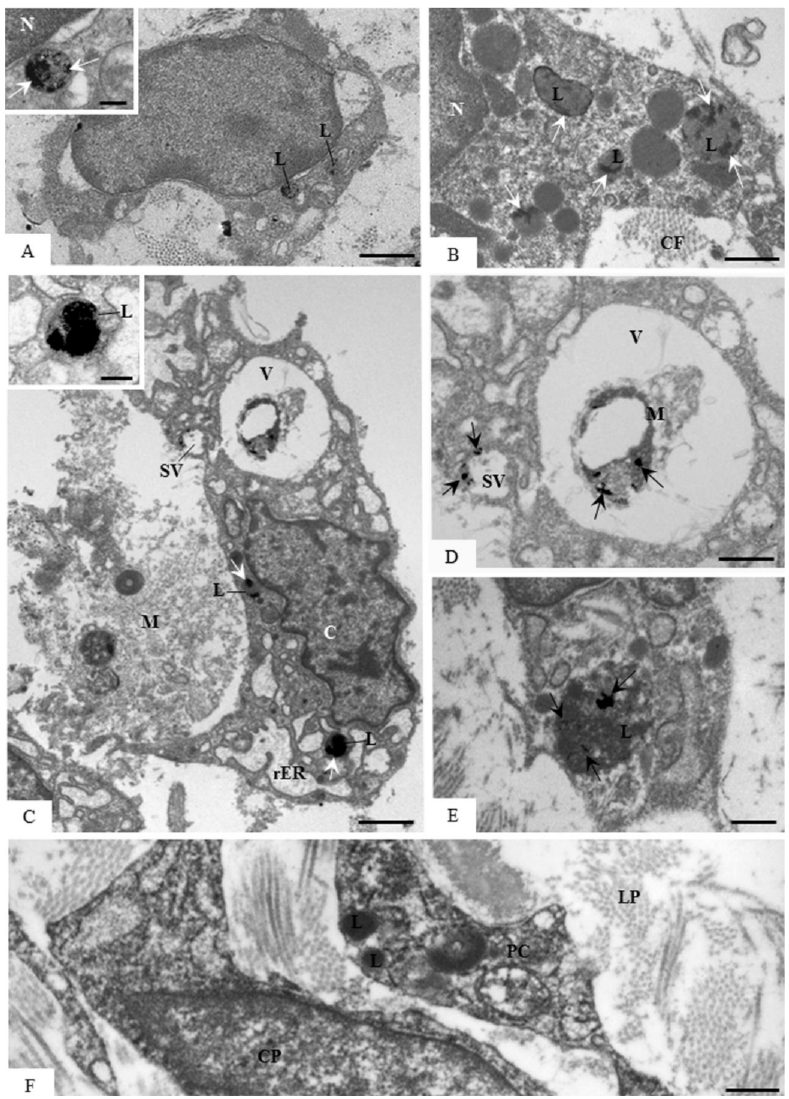
Figure 9. Electron micrographs of portions of lamina propria of the eruptive pathway of first molars of 9- ( A ), 13- ( B and F ), 16- ( C – E ) day-old rats. A – E —portions of the eruptive pathway of first molars incubated for acid phosphatase reaction. A —a round-shaped cell exhibits electron-opaque deposits in the lysosomes (L). In high magnification (inset), conspicuous electron-opaque deposits (arrows)—reaction product of the acid phosphatase activity—is irregularly distributed throughout the lysosome. N, nucleus. Bars: 5 µ m and 0.2 µ m (inset). In B , several lysosomes (L) exhibiting electron-opaque deposits (arrows) are observed in the cytoplasm of a macrophage. N, nucleus; CF, collagen fibrils. Bar: 1.5 µ m. C —an irregular cell (C) with large vacuole (V) is surrounding partially a heterogeneous material (M). Electron-opaque deposits (arrows) are observed in the lysosomes (L) and in the periphery of a small vacuole (SV). The inset shows conspicuous electron-opaque deposits almost entirely filling a lysosome (L). rER, rough endoplasmic reticulum. Bars: 4 µ m and 0.3 µ m (inset). D —high magnification of the large vacuole (V) observed in the superior portion of the Figure 9C. Fine products of the reaction to acid phosphatase (arrows) are observed on the partially digested material (M). Granular electron-opaque deposits (arrows) are also seen in the periphery of a small vacuole (SV). Bar: 1 µ m. Figure 9 E —a large lysosome (L) exhibiting acid phosphatase-positive deposits (arrows) intermingled with heterogeneous material is present in the fibroblast. Bar: 0.5 µ m. F —ultrathin section of a portion of the eruptive pathway incubated in substrate-free medium (negative control). No reaction product is observed in the lysosome (L) of cellular portions (CP) in the lamina propria (LP). Bar: 1.5 µ